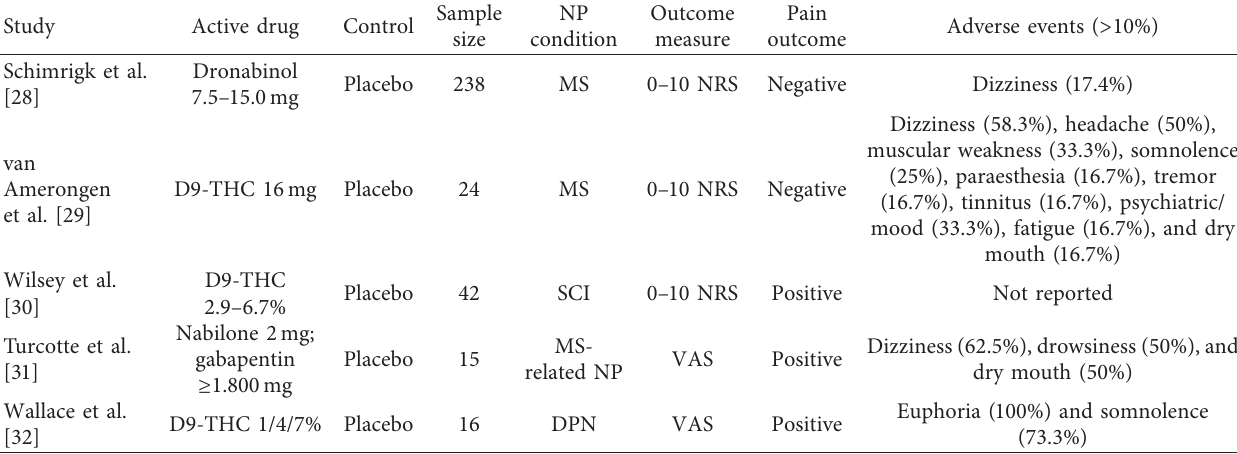
Table 5: Randomized, double-blind, controlled trials testing the effect of cannabinoids.